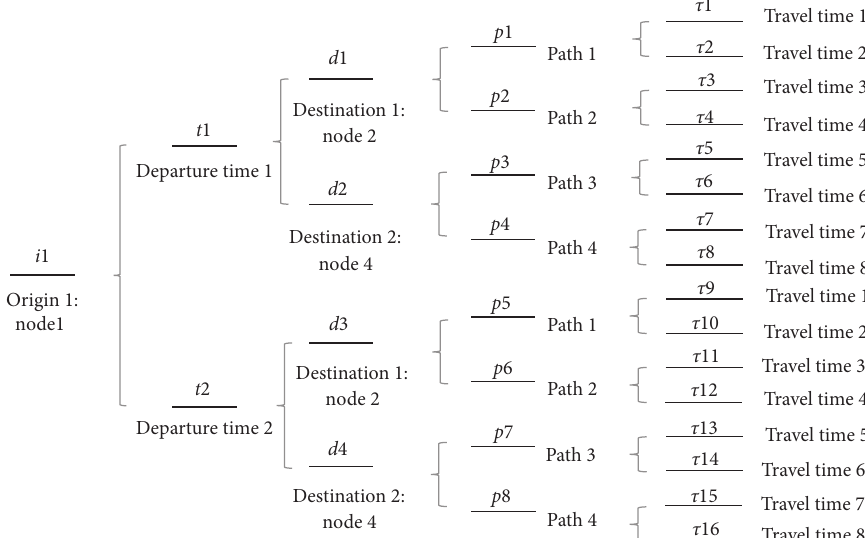
Figure 3: Illustration of the time-dependent hierarchical passenger